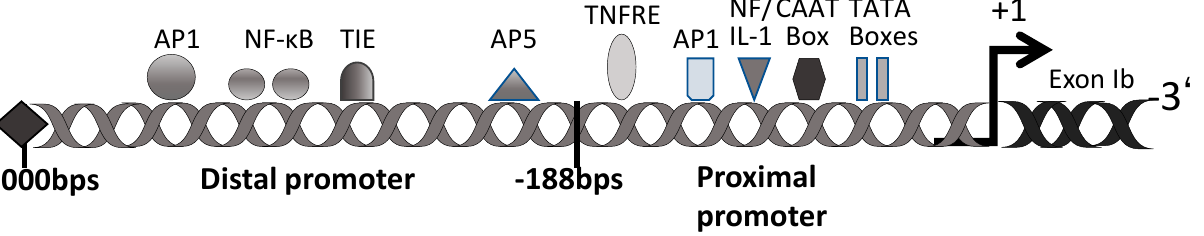
Figure 2. Schematic representation of the human decorin promoter. Consensus sequences for cis- regulatory elements are labeled.